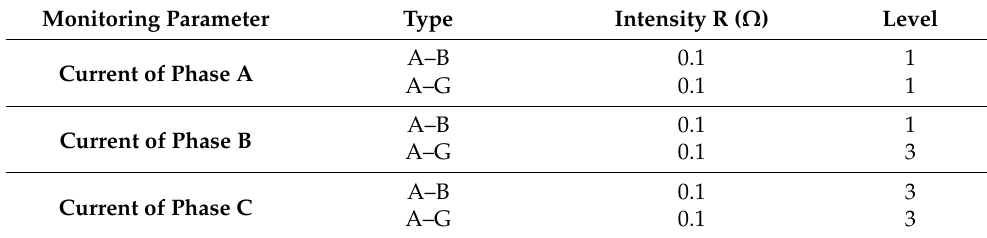
Table 6. Operation with fault at 1.9–2.2 s for step load torque.